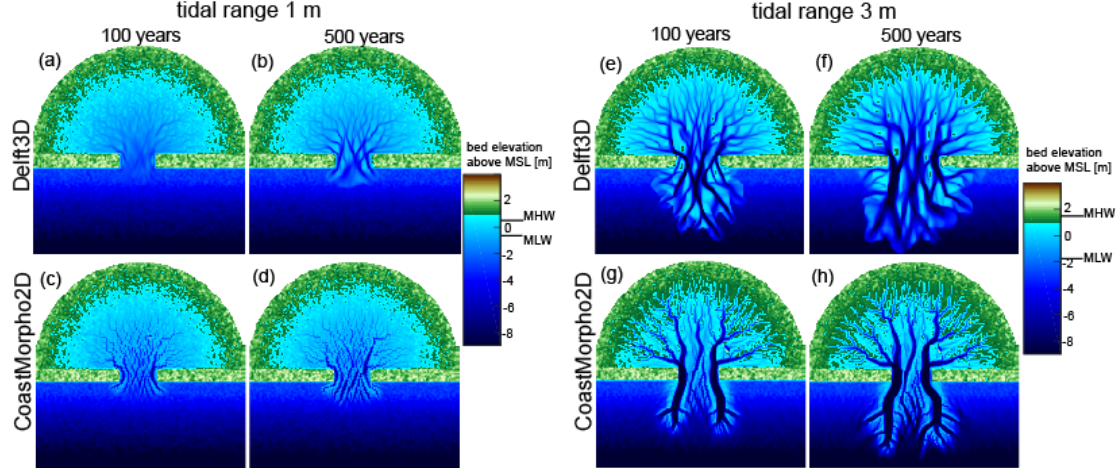
Figure 11. Comparison between Delft3D and CM2D for different tidal ranges. Simulations are compared at year 500 with the reference parameters (Figure 5e). ( a – d ) Tidal range equal to 1 m; ( e – h ) Tidal range equal to 1 m. Note the change in the MHW and MLW levels on the elevation scale.